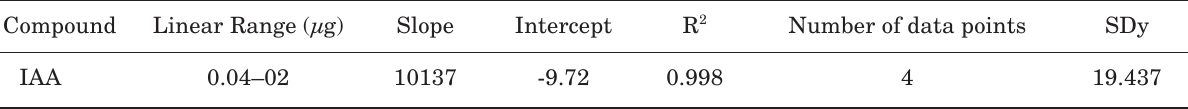
Table 2. Characteristics of the calibration curves of indole-3-acetic acid (IAA).